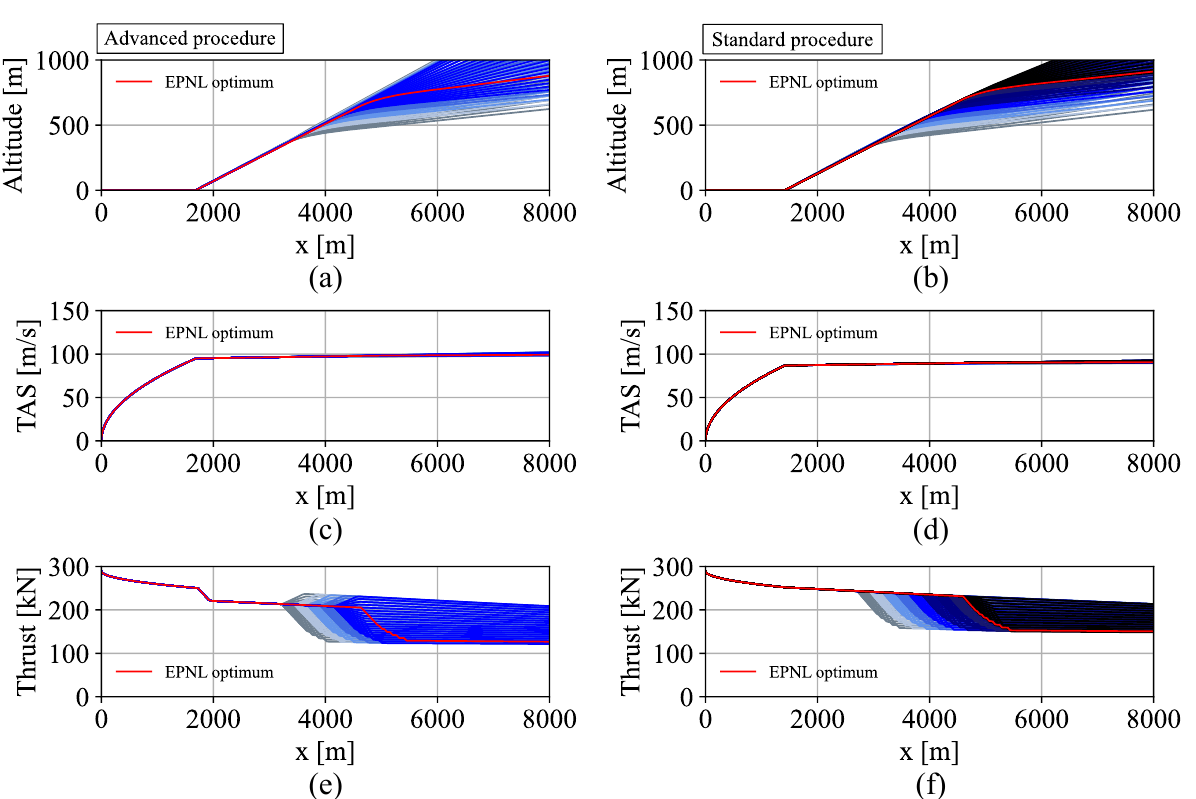
Figure A2. Flight altitude ( a , b ), True Air Speed ( c , d ) and Thrust ( e , f ) over X in the form of the distance to the brake release point is plotted for all trajectories considered in the flight path optimization. On the left side are all advanced and on the right side all standard departure procedures. The EPNL optimum, i.e., the trajectory with the lowest EPNL at flyover position is colored in red and trajectories with the same cutback height are assigned to one specific color (grey = lower, blue = middle, and black = higher cutback